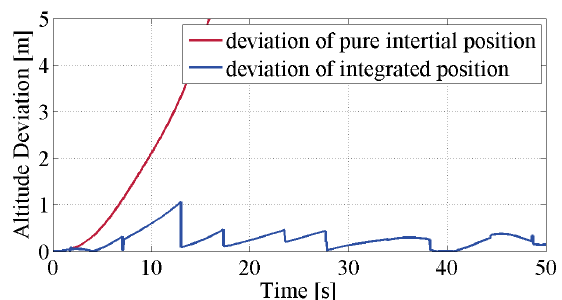
Figure 9: Deviation of estimated altitude of INS and integrated navigation